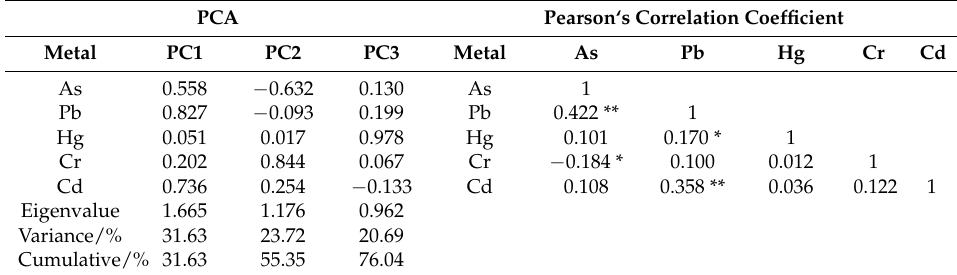
Table 4. Principal component analysis (PCA) and correlation coefficients of metals in Suzhou soils.